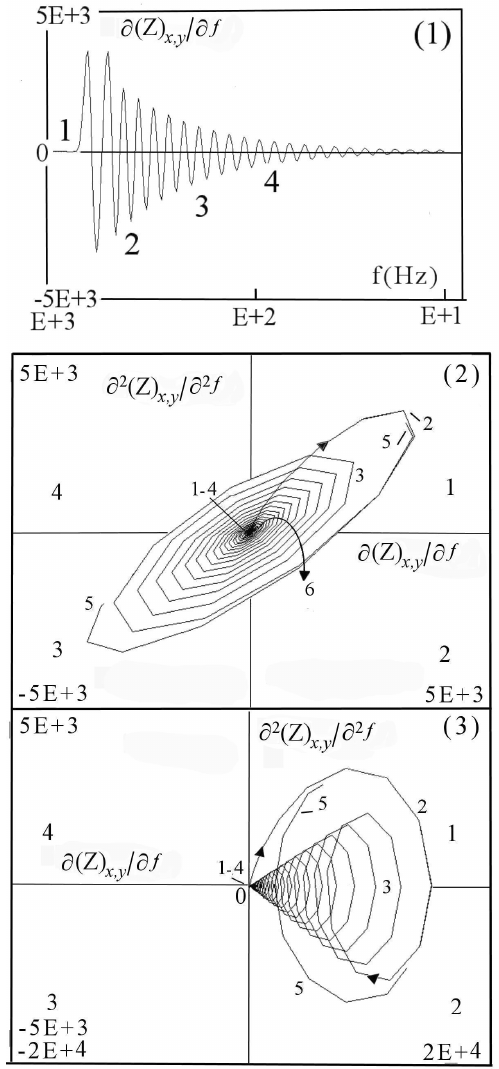
Figure 19. ( 1 ): Instability depending on impedance between peak A and shoulder B; ( 2 , 3 ): phase- space at high frequency for closed spiral and open-route at different viewing